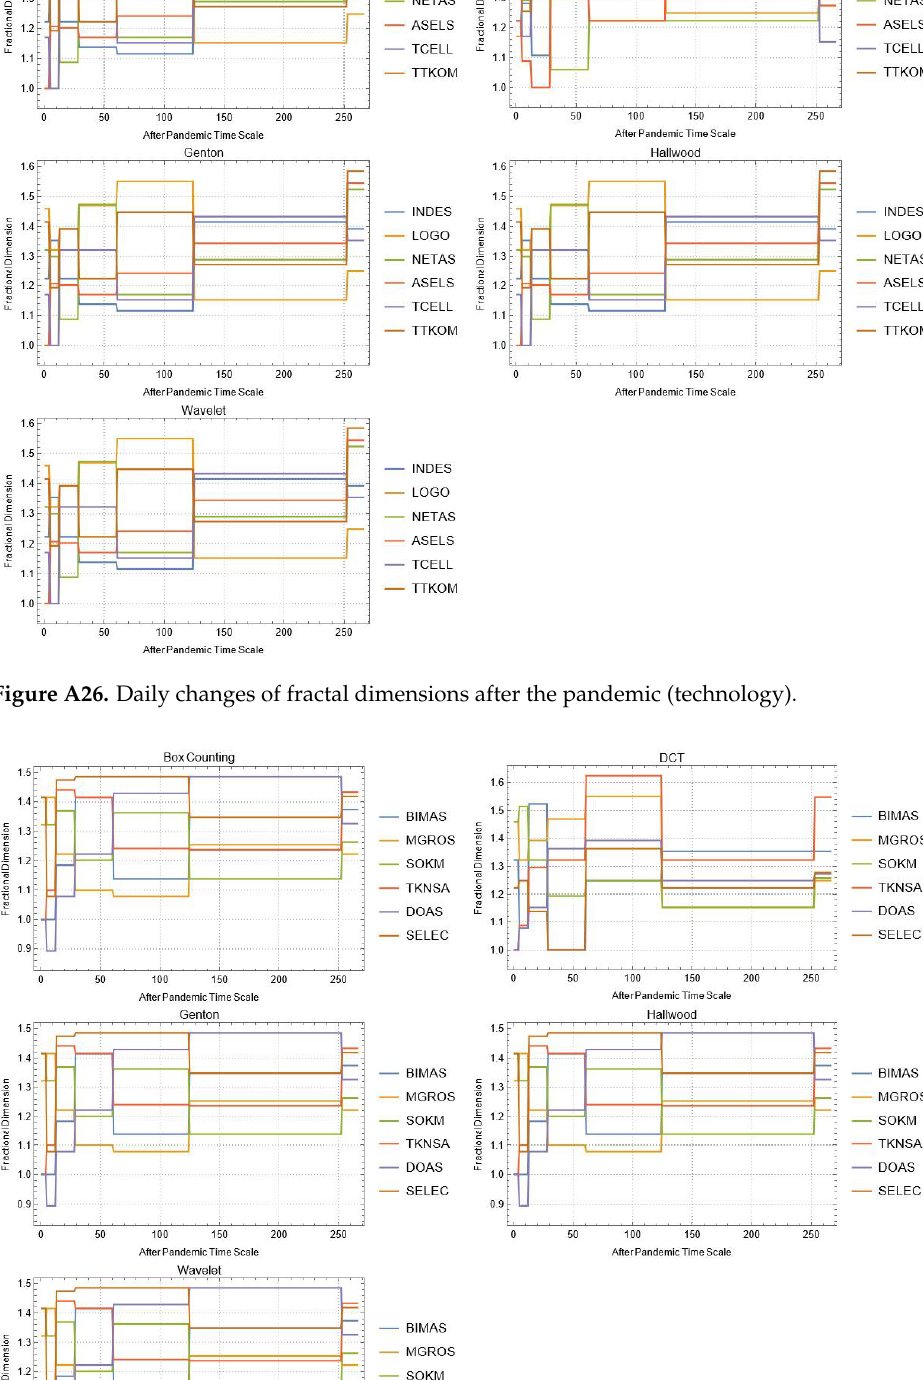
Figure A25. Daily changes of fractal dimensions after the pandemic (holdings–investment companies).